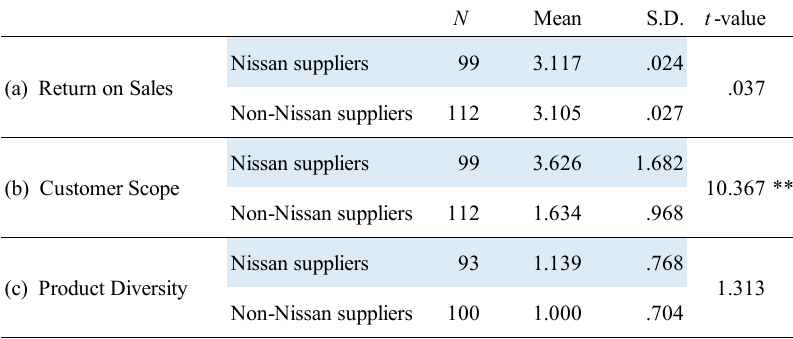
Table 4. Comparisons between Nissan suppliers and non-Nissan suppliers